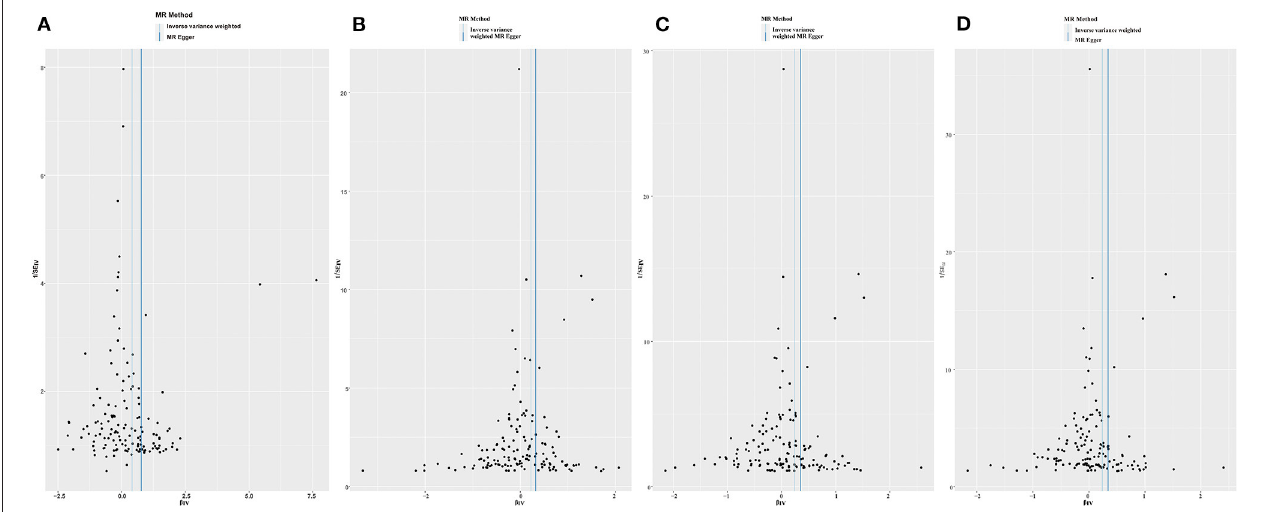
FIGURE 3 | Funnel plots to visualize overall heterogeneity of Mendelian randomization (MR) estimates for the effect of LDL-C on the risk of individual (A) , paternal (B) , maternal (C) , and family (D) history of Alzheimer’s disease.